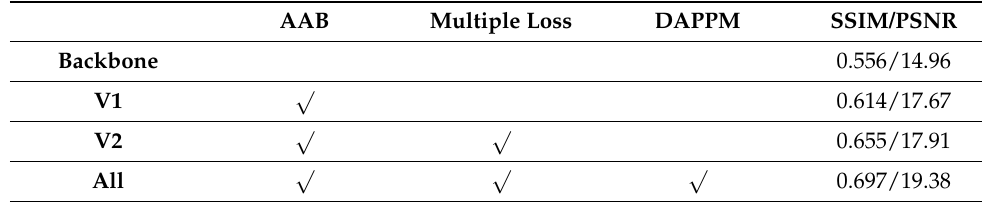
Table 4. Performance of the